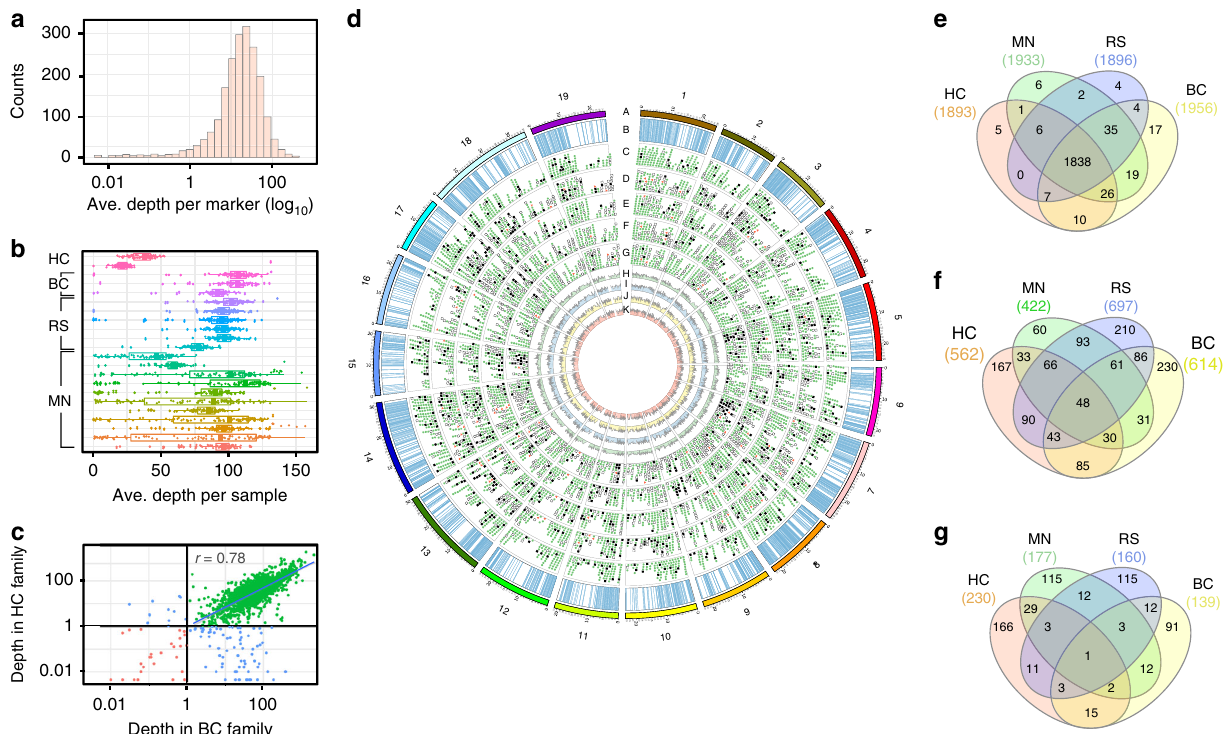
Fig. 3 Performance of 2,000 rhAmpSeq markers in four families. a Distribution of average depth of markers on a log10 scale. b Average depth per sample in all plates of four families. Each point represents one sample in the plate. The bound box represents the 25th or 75th percentiles and the whiskers extends to 1.5 times of the interquartile range. c Correlation of read depth in two families. The Pearson correlation coef fi cient was calculated for the markers with average depth larger than one in both families. d Circos plot of marker performance in four families and the metapopulation. a denotes Chromosomes; b denotes physical locations of rhAmpSeq core genome markers; c – g denote rhAmpSeq markers that failed to return data (red triangle), distorted (black square), monomorphic (white square) and on linkage map (green circle) for consensus genetic map, HC, MN, BC and RS families; h – k denote read depth across for each marker in HC, MN, BC, RS families, respectively. e Venn diagram of the markers with average read coverage greater than 1 across the four families. f Venn diagram of the monomorphic markers in four families. g Venn diagram of the distorted markers in four ( χ 2 , two-tailed chi-squared test, P < 1E-6), as was the variance of